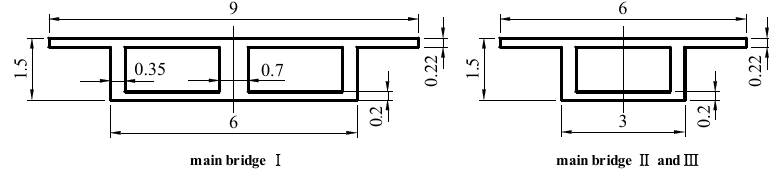
Figure 3. Cross-sections of the typical irregularly-shaped bridge (unit:m).